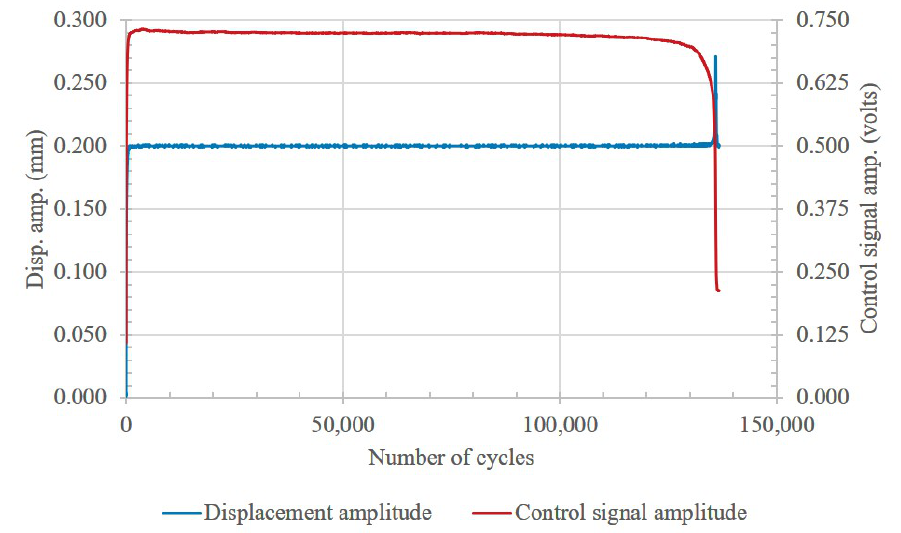
Figure 8. Displacement and control signal amplitude up to the entire fatigue life cycle of a fine finished wrought specimen.